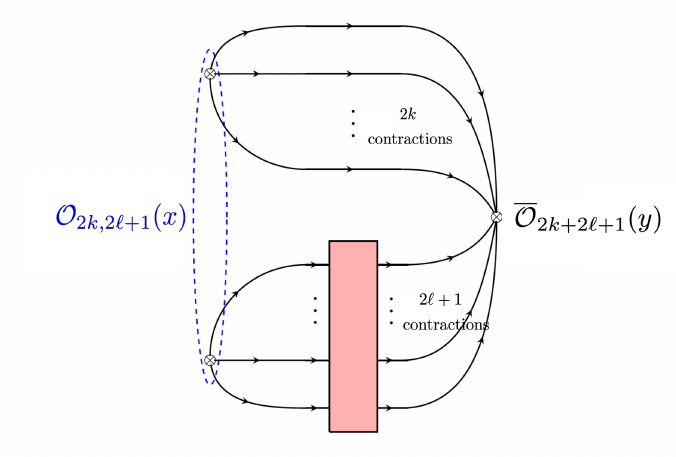
Figure 6 . By contracting all legs with the tree-level propagators one obtains the coefficient G (0) n whose leading term at large N is given in (3.7).